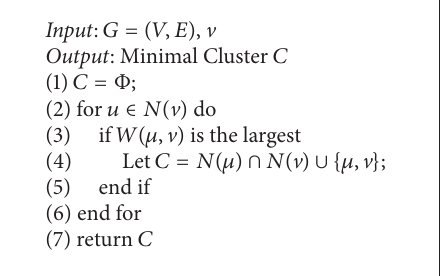
Algorithm 1: Locating minimal